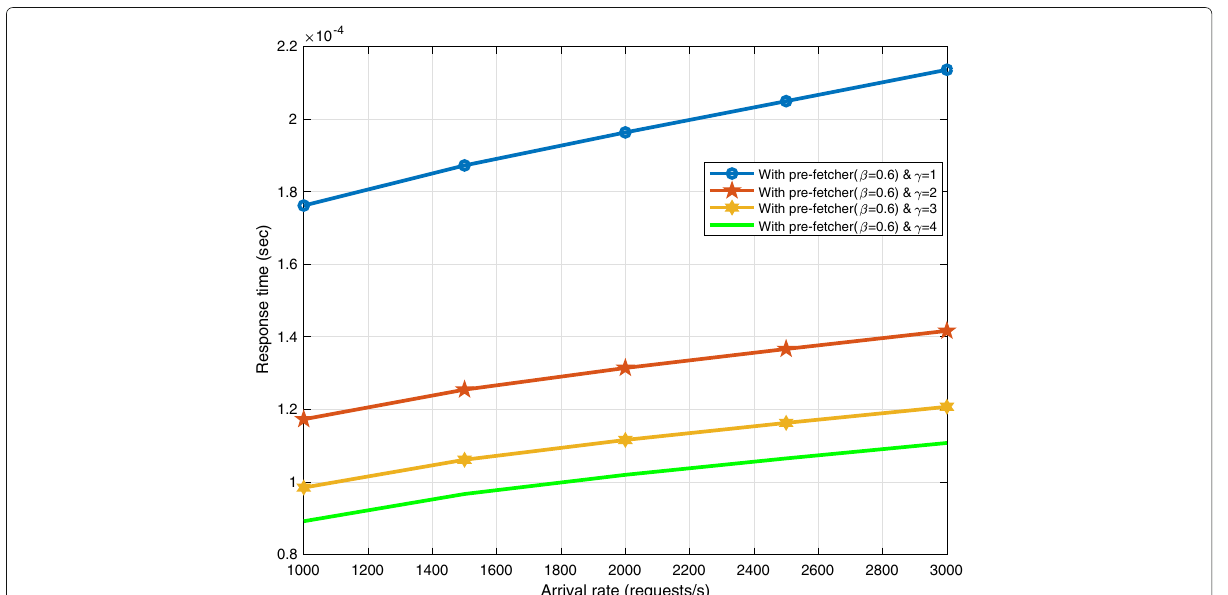
Fig. 6 Workload response time vs. arrival rate while the workload is shared between multimedia cloud and pre-fetcher at probability distribution of β = 0.6. With pre-fetcher ( β = 0.6) and γ = 1, With pre-fetcher ( β = 0.6) and γ = 2, With pre-fetcher ( β = 0.6) and γ = 3, With pre-fetcher ( β = 0.6) and γ = 4,